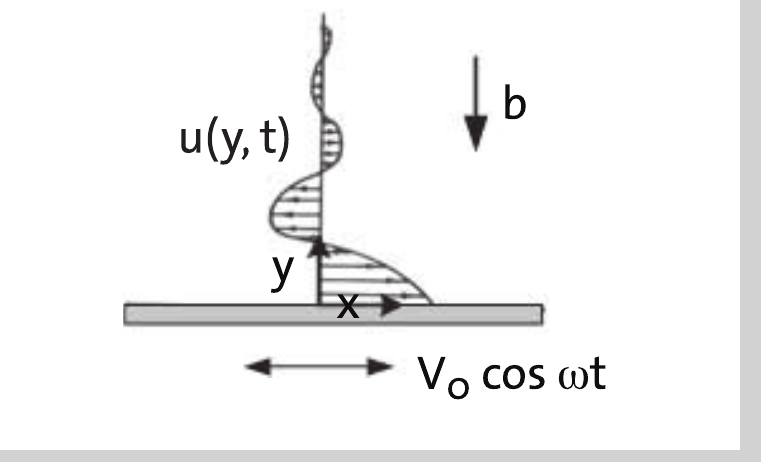
Figure 1: Sketch of an unsteady flow above an oscillating plate (Stokes’ second problem) and the coordinate